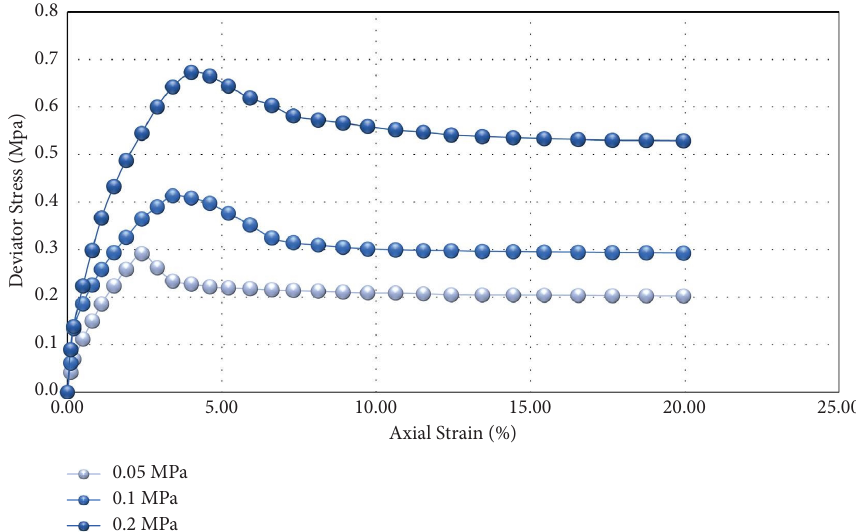
Figure 5: Deviator stress-strain curves for sample LR8 (8% LRHA treated soil 1 :2) after 28 days.